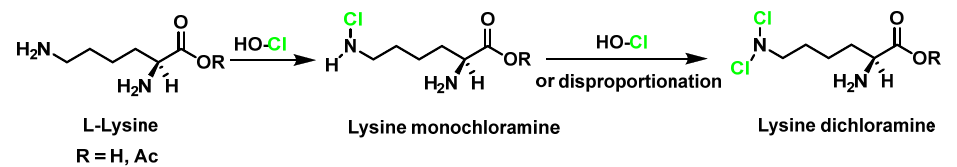
Figure 27. HOCl reaction with Lys and formation of monochloroamine and dichloroamine. Using spectrophotometric techniques, HOCl and L-Arg were found to react rapidly (k = 7.1 × 10 5 m − 1 s − 1 ) to form two main products which were identified by mass spectrometry as monochlorinated and dichlorinated adducts of L-Arg [79], as shown in Figure 28.